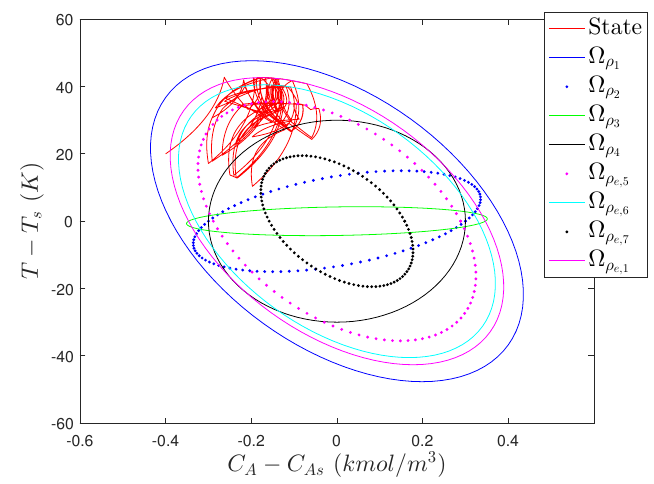
Figure 9. State-space trajectories under the randomized LMPC implementation strategy for the CSTR of Equations (46) and (47). For simplicity, only one level set for each of the n p potential LMPC’s is shown ( Ω ρ is shown if V i (cid:54) = V 1 , and Ω ρ is shown if V i = V 1 , i > i e , i